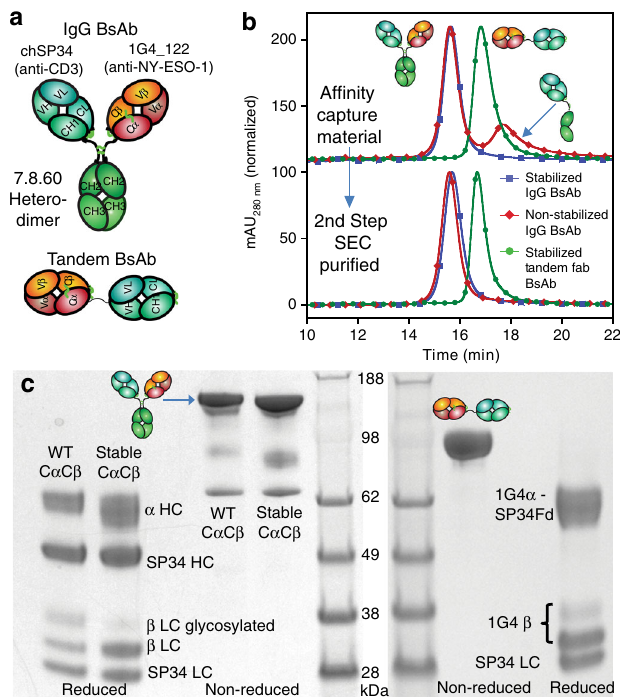
Fig. 6 Characterization of IgG-like TCR/CD3 proteins. a Schematic diagrams of the TCR/CD3 bispeci fi c (BsAb) molecules. b Analytical SEC chromatogram and c Non-reduced and reduced SDS-PAGE of the IgG BsAbs using the wild-type NY-ESO-1 TCR and a stabilized NY-ESO-1 TCR as well as a tandem Fab BsAb using only the stabilized NY-ESO-1 TCR. Source data are available in the Source Data fi